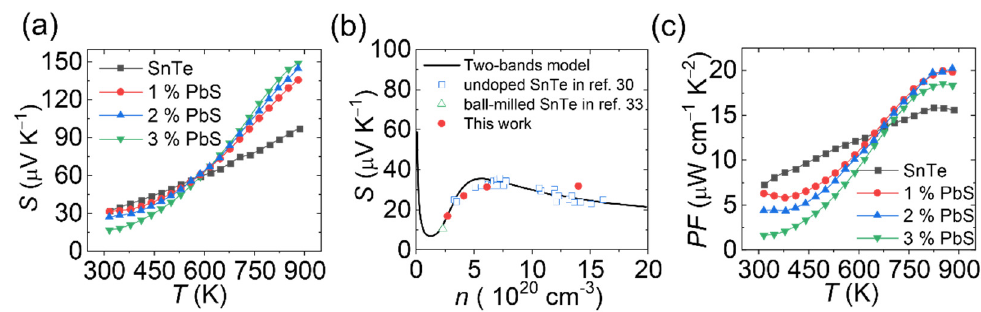
Figure 6. ( a ) The Seebeck coefficient as a function of temperature; ( b ) the Pisarenko relationship at room temperature; ( c ) the power factor as a function of temperature.